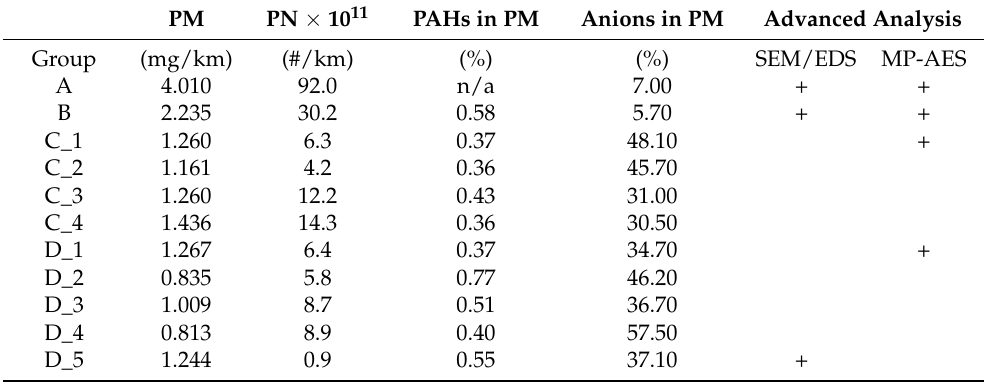
Table 7. General results of the analysis conducted in this study. Mean PM and PM values from the WLTC tests, concentrations of studied PAHs and anions in the solid particles, and information about additional analysis with the use of SEM/EDS or